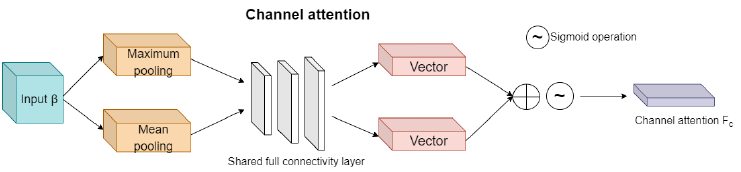
Figure 5. Channel attention